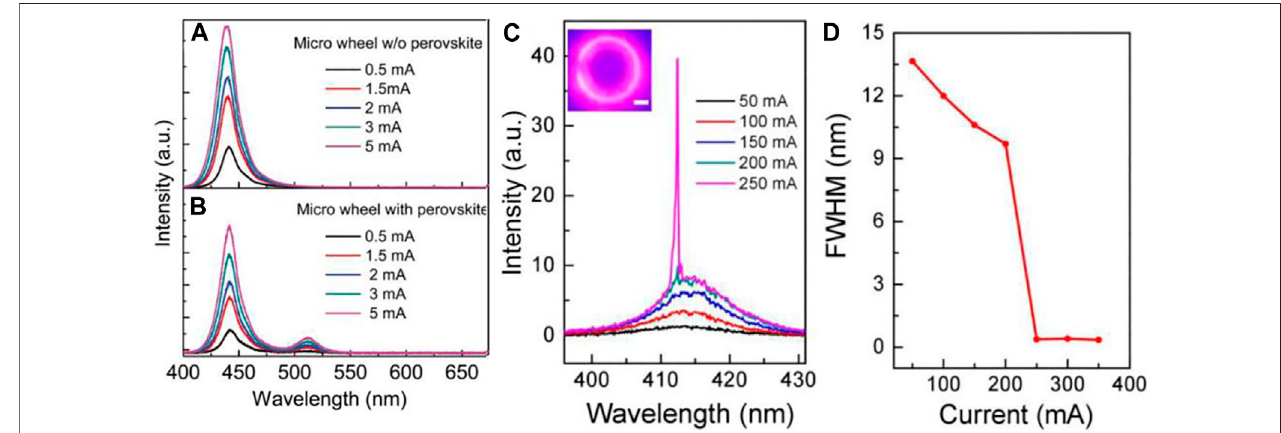
FIGURE 9 | EL spectra of a GaN microwheel (A) without and (B) with CH 3 NH 3 PbBr 3 at varying currents (Zhu et al., 2020b). (C) EL spectra of an as-fabricated InGaN-based microring laser grown on an Si substrate (Feng et al., 2021). (D) Relationship between the FWHM of EL spectra and the pulsed injection current in Figure 9C . Reprinted with permission © Elsevier Publishing (Feng et al., 2021), © IOP Publishing (Zhu et al., 2019).